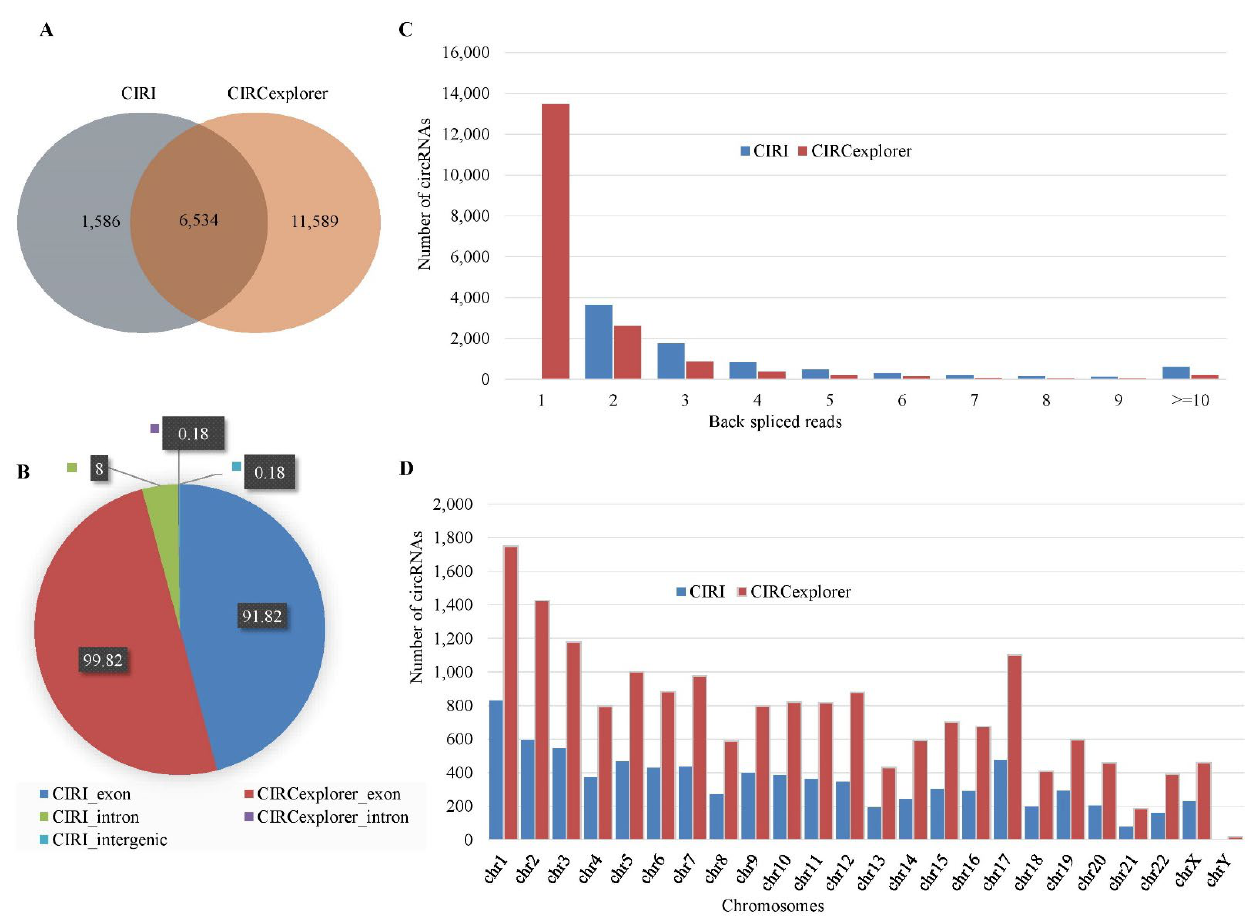
Figure 1. Expression profile of circRNAs in human data. ( A ) Venn-diagram of the circRNAs identified by CIRI and CIRCexplorer. ( B ) Distribution of the genomic origin of the circRNAs (%). ( C ) Distribution of the number of back-spliced reads spanning the circRNAs. ( D ) Chromosome distribution of the identified circRNAs.